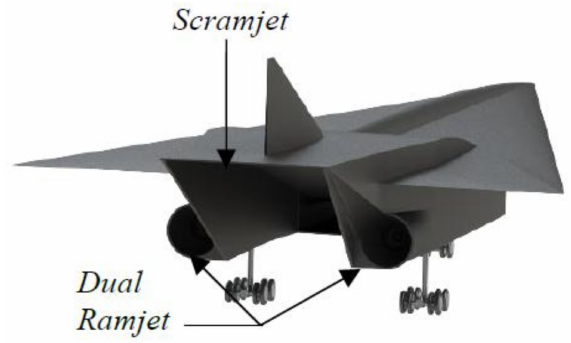
Figure 2. Concept hypersonic aircraft.